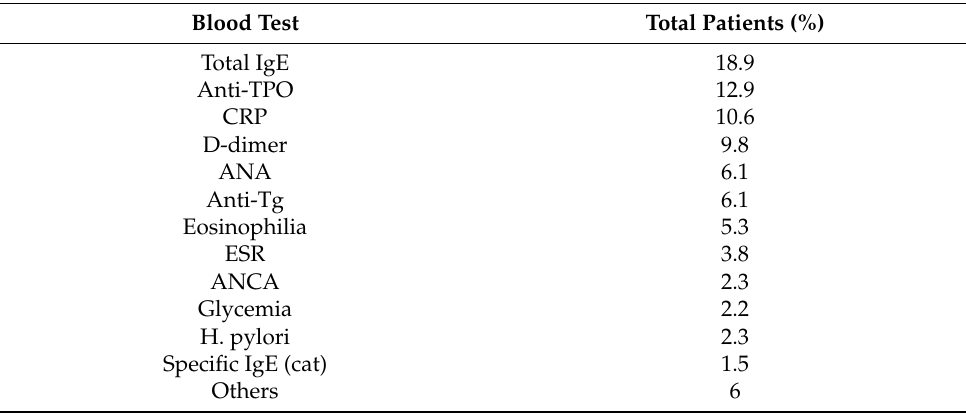
Table 3. Most frequent abnormal blood test from South Italian CSU